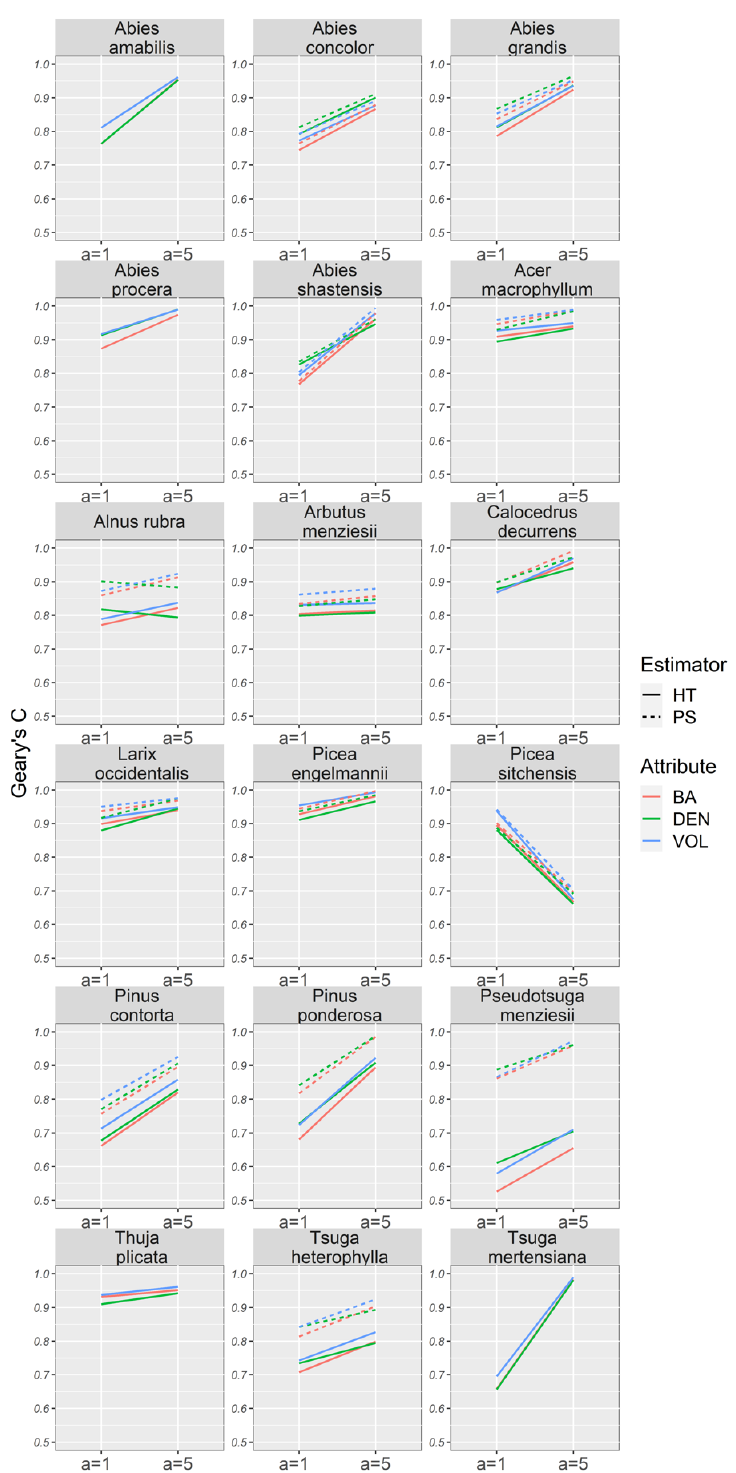
Figure A1. Changes between Geary’s C calculated with all field plots and the mean Geary’s C calculated using all subsamples collected from a systematic sample of interval a = 5. Note that in some cases, the Geary’s C between attributes and HT and PS residuals can be very similar, resulting in overlapping lines in the figure.